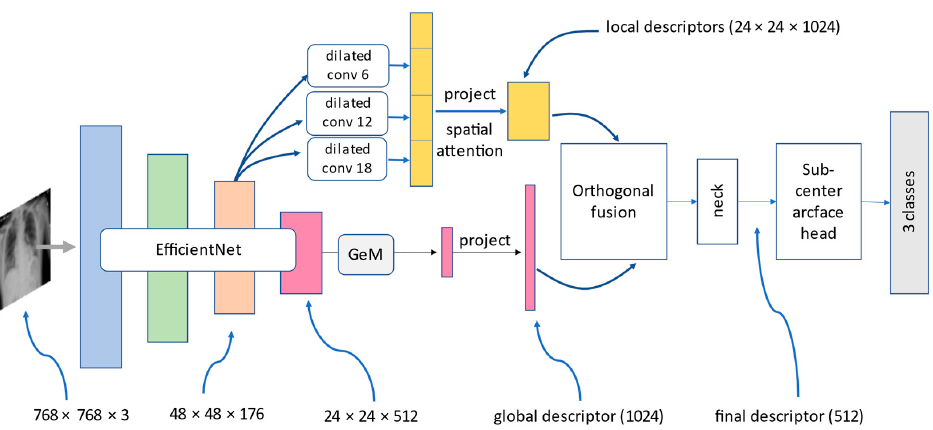
Figure 3. Hybrid EfficientNet-B5 and DOLG architecture.